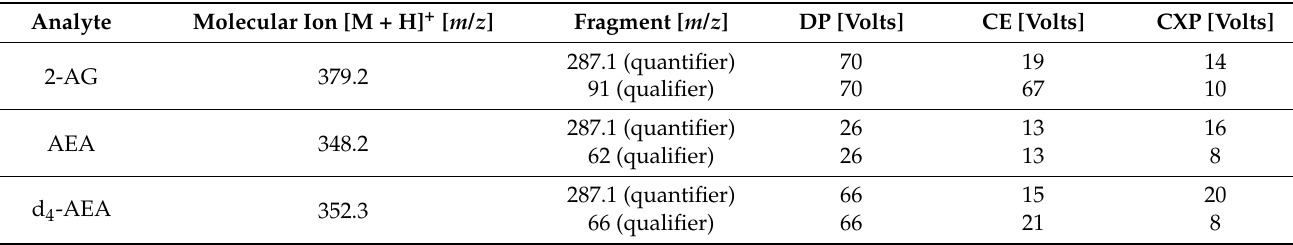
Table 3. MRM transitions for eCB measurements in ESI +